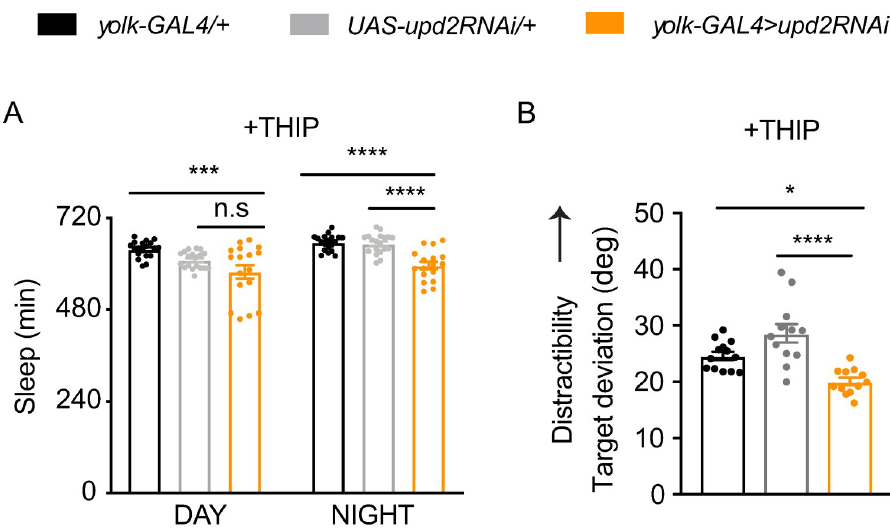
Fig 7. Additional sleep does not restore attention in upd2 knockdown flies. (A) Total sleep duration in THIP-fed flies (0.1 mg/mL) was increased (compared with the same genotypes in Fig 2). upd2 knockdown flies still showed a significant decrease in their sleep duration compared with genetic controls ( n = 17–19). (B) Additional sleep via THIP did not rescue the improved attention phenotype of flies with FB upd2 knockdown (orange, yolk-GAL4 > upd2RNAi ) compared with controls ( yolk-GAL4/+ , black, and UAS-upd2RNAi/+ , gray) ( n = 12–13). One-way ANOVA with Tukey correction was used for comparing different conditions. � P < 0.05, �� P < 0.01, ��� P < 0.001, ���� P < 0.0001; error bars show SEM. The data underlying this figure can be found in S1 Data. FB, fat body; GAL4, galactose- responsive transcription factor; RNAi, RNA interference; UAS, upstream activation sequence upd2 , unpaired 2.